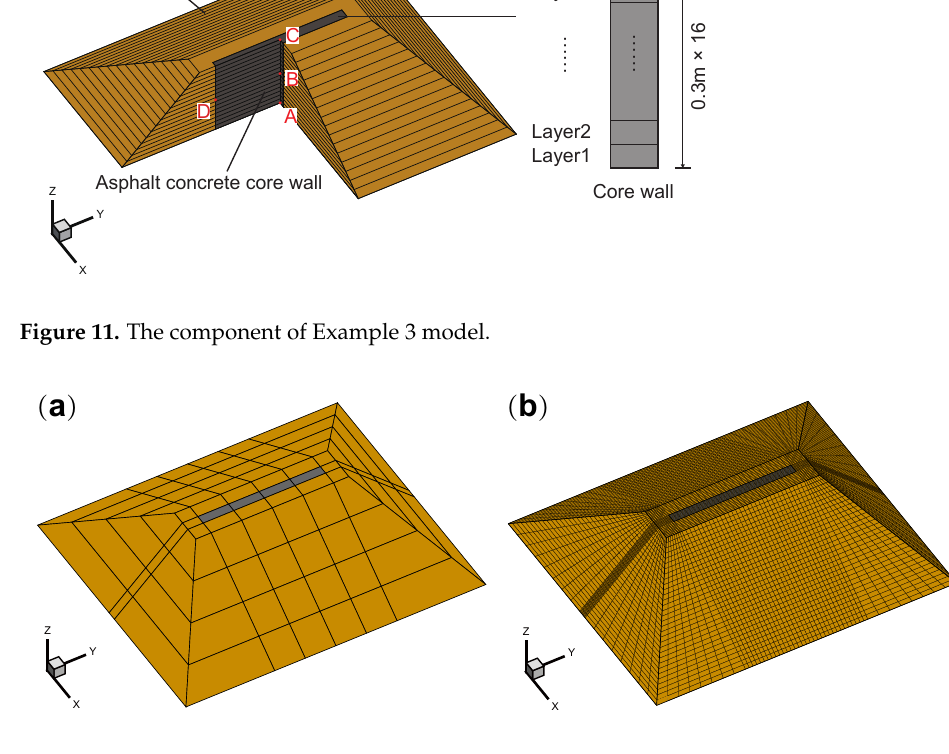
Figure 12. The mesh of Example 3: ( a ) The initial coarse mesh. ( b ) The initial computational